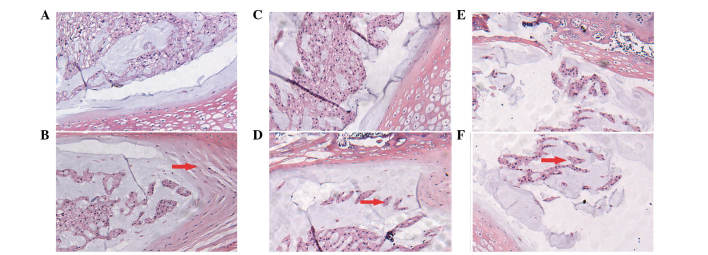
Photomicrographs showing histological analysis of the transected disc samples. Hematoxylin and eosin (H&E) staining: (A), (C) and (E) show the apparently normal histological structure of the disc at 4, 8 and 12 weeks in the control group. (B), (D) and (F) show the histological structure of the discs exhibiting a gradual degeneration process at the different time points. Arrows in (B) and (D) show a reduction in notochordal cells. The arrow in (F) shows the disruption of the annulus fibrosus. Original magnification, ×100.